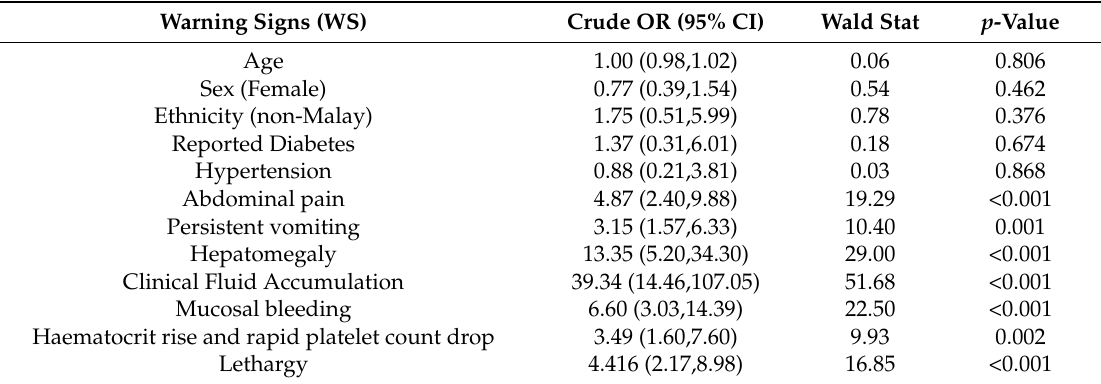
Table 6. Simple logistic regression analysis of factors associated with